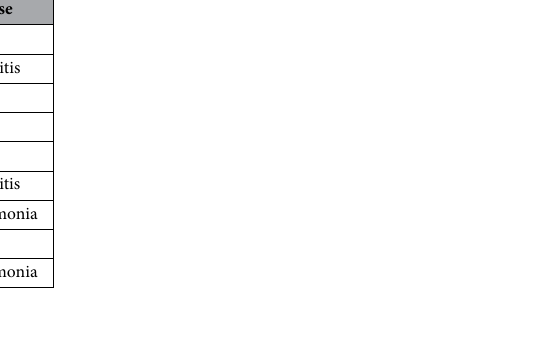
Table 1. Hospital medical